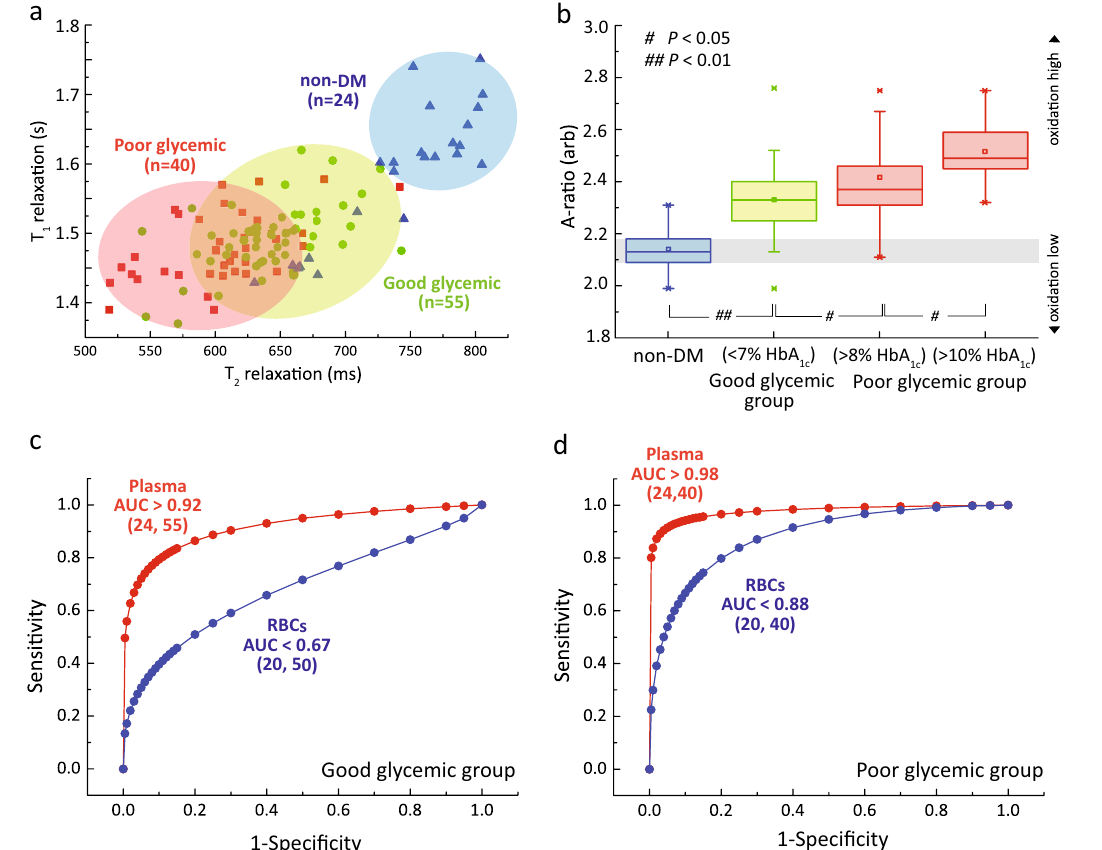
Fig. 5 Baseline measurements of oxidative stress in plasma. a The T 1 – T 2 relaxometry coordinates of plasma baseline taken from healthy non-DM subjects (blue, n = 24), subjects with good glycaemic control (green, n = 55) and subjects with poor glycaemic control (red, n = 40). b The corresponding A-ratio against the subjects with poor glycaemic control and good glycaemic control subgroups, as compared to healthy non-DM subjects. The subjects with poor glycaemic controls were further subdivided into >8% HbA 1c ( n = 15) and >10% HbA 1c ( n = 25) subgroups. The statistical signi fi cance was calculated using the Student ’ s T-test (two-tailed, unequal variance). The data is represented by box- plot format. The diagnostic accuracy of RBCs (blue) and plasma (red) taken from non-DM subjects and DM subjects, where their glycaemic subgroups were c good glycaemic control and d poor glycaemic control subgroups. The number of subjects ( n ) is indicated in